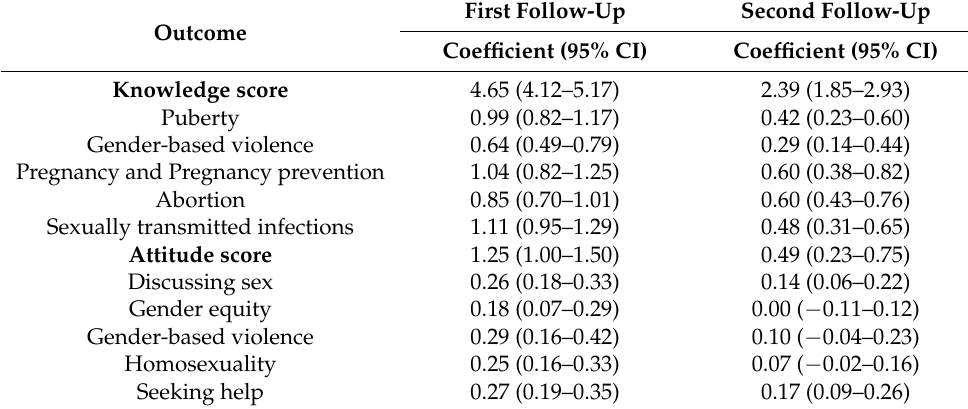
Table 3. Estimated curriculum’s effect on sexual knowledge and attitudes a ( n = 501).